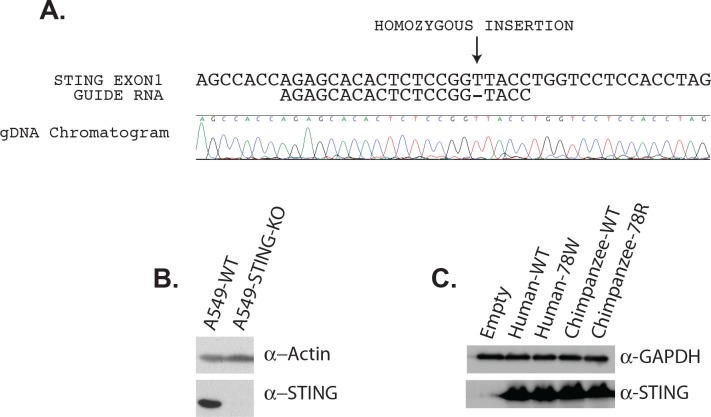
Generation of STING knockout cells using CRISPR-Cas9, and stable re-complementation of these lines.(A) A depiction of the insertion induced in the first exon of STING in A549 cells. Below, a Sanger sequencing chromatogram from a this genomic locus shows the homozygous insertion. (B) Both wildtype (wt) A549 cells and A549 cells that were knocked out for STING were probed by western blot for Actin or STING. An antibody recognizing the endogenous STING was used (anti-STING; Abcam 92605). (C) STING-KO A549 cells were re-complimented with HA-tagged versions of STING using lentiviral transduction. Cell lines were generated to express either wildtype (wt) or mutant STING from human or chimpanzee. A mutation was made in human STING to render it cleavage-resistant (78W). A mutation was made in chimpanzee STING to make it cleavage-susceptible (78R). Western blots where performed with antibodies against GAPDH or STING.